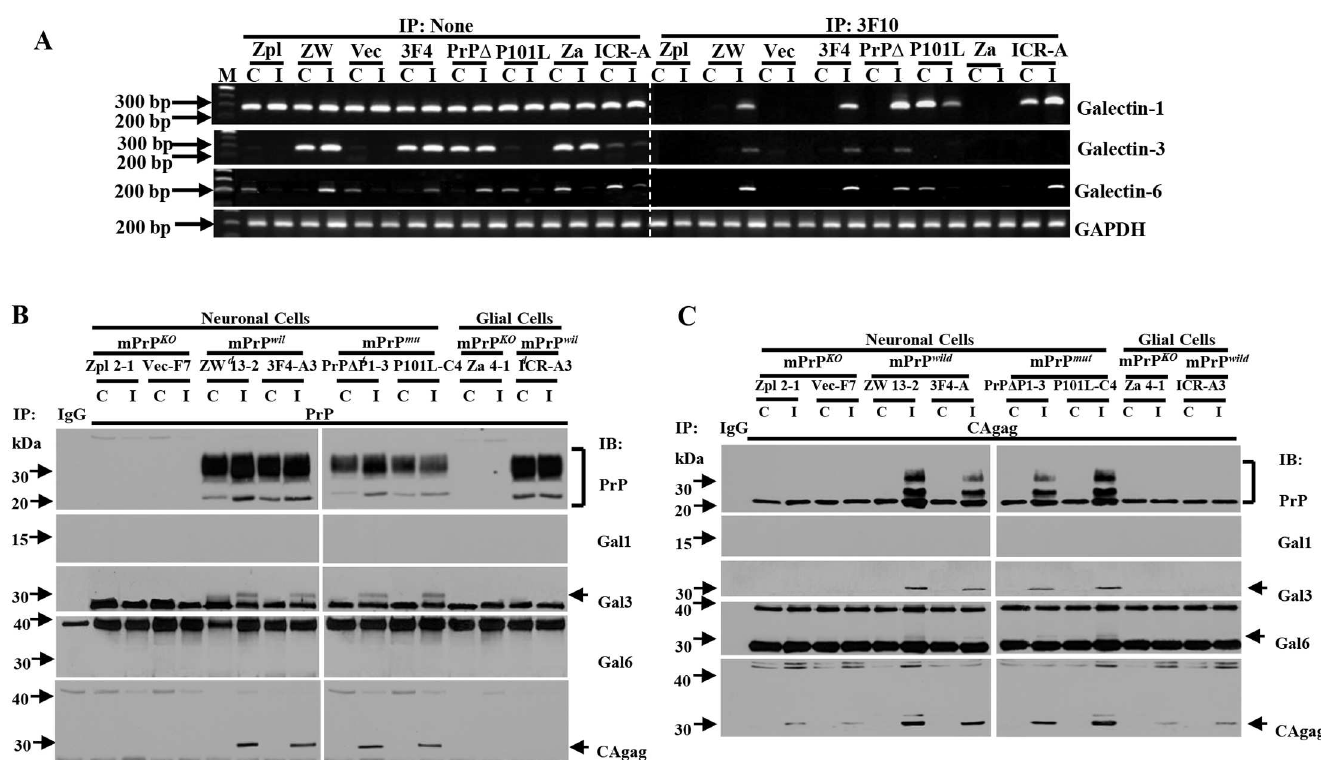
Fig 6. Expression and binding activity of PrP C with galectin-1,-3, and -6 mRNAsand proteins. (A) Expression of mRNA levels of galectin-1,-3, and -6 was observedby quantitative RT-PCR method. Bindingactivity of PrP C with galectin-1, -3, and -6 mRNAs was investigatedby immunoprecipitation of mRNA-protein complex method using anti-PrP antibody (anti-3F10). Galectin-1mRNA is constitutivelyexpressed regardlessof no infectionor MuLV infection. Galectin-3mRNA expressionis closely related with PrP C expression, thus it is detected in PrP C -expressing neuronalcells but not in PrP -/- neuronalcells. Galectin-6mRNA expressionis related to MuLV infection in PrP C -expressing cells but not in PrP -/- cells, P101L cells and PrP +/+ astroglial cells. Bindingactivity of PrP C to galectin mRNAs was closely related to MuLV infectionin PrP +/+ cells. For P101L cells, the bindingactivity to galectin-1and -6 was unusualin that bindingoccurred in non-infected cells. This may have contributedto the large plaquesize seen in P101L cells. (B) Anti-PrP (3F10) antibody was used to proceedimmunoprecipitationthen anti-PrP (3F10) (27–33kDa), -galectin-1 (Gal1)(14 kDa), -galectin-3(Gal3)(31 kDa), -galectin-6 (Gal6)(32 kDa), and –CAgag (30 kDa) antibotieswere used to detect expressionlevel of each protein. PrP was detected in all PrP expressingcell lines: ZW, 3F4, PrP Δ , P101L, and ICR cell lines regardless of infected or non-infected.CAgagand Gal3 was detected in MuLV-infected neuronalcell lines: ZW, 3F4, PrP Δ , and P101L cell lines. Gal1 and Gal6 was not detected in any of cell lines regardlessof infected or non-infected. (C) Anti-CAgag antibody was used to proceedimmunoprecipitation then anti-PrP (3F10) (27–33kDa), -galectin-1(Gal1)(14 kDa), -galectin-3(Gal3)(31 kDa), -galectin-6(Gal6)(32 kDa), and –CAgag(30 kDa) antibotieswere used to detect expressionlevel of each protein. CAgagwas detected in all MuLV infected cells and Gal1 was not detected. PrP, Gal3, and Gal6 was detected at MuLV-infected PrP +/+